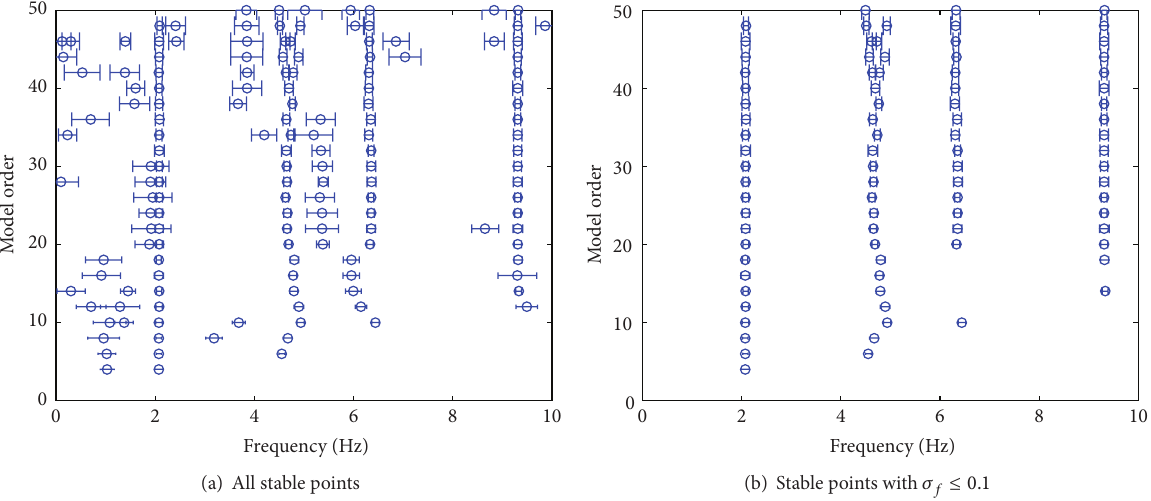
Figure 9: The footbridge: SD with confidence.